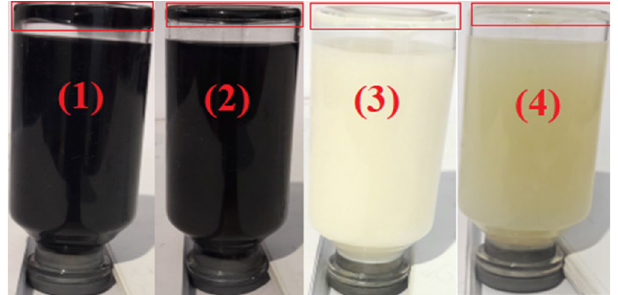
Figure 9. Camera pictures of nano lubricants after 6 days (1) 0.4 wt.% of MWCNTs, (2) 0.05 wt.% of MWCNTs, (3) 0.4 wt.% of TiO